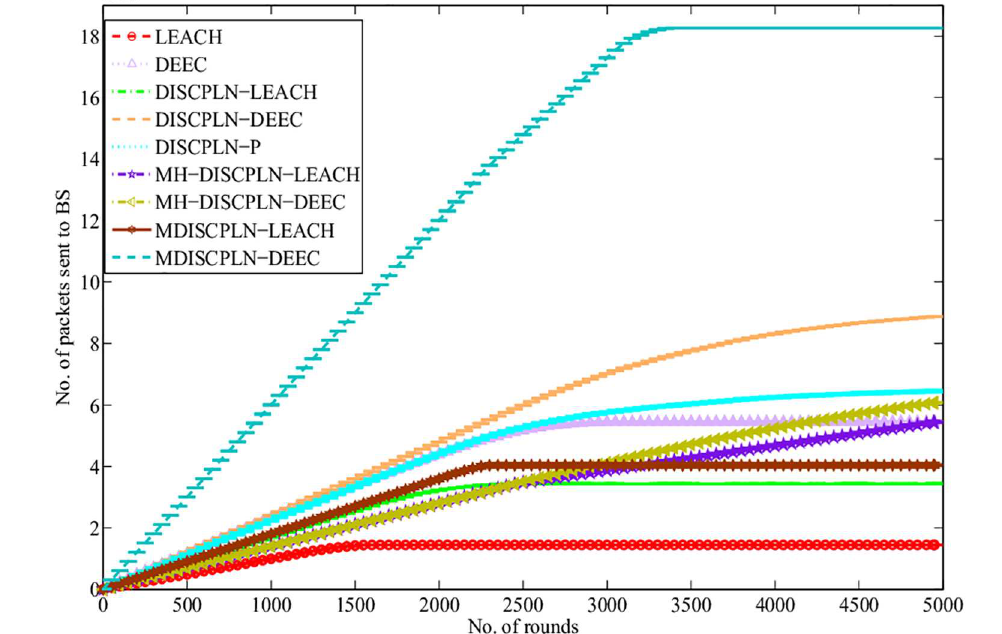
Fig 16. Performance comparison on the basisof network